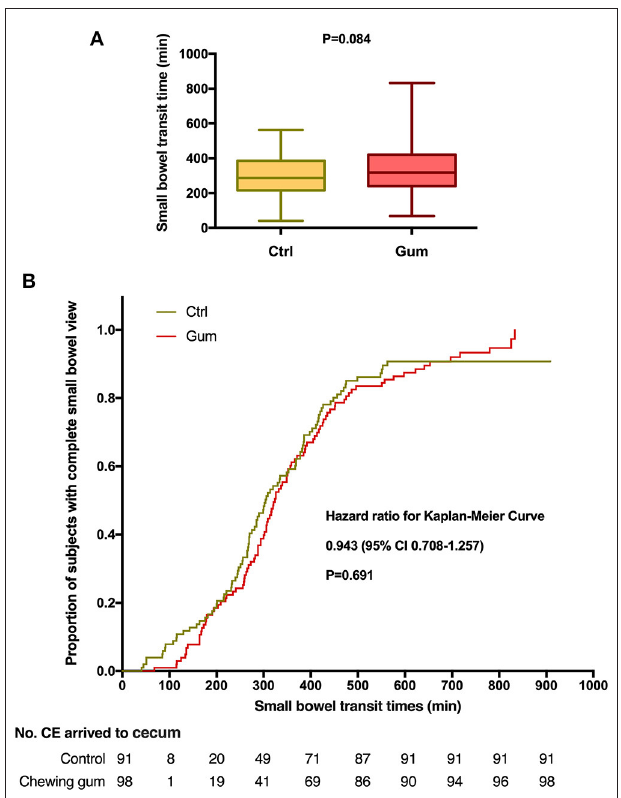
FIGURE 3 | Small bowel transit time during capsule endoscopy in the chewing gum group and control group. (A) A boxplot with medians and quartiles; (B) Kaplan–Meier curves for time to complete small bowel